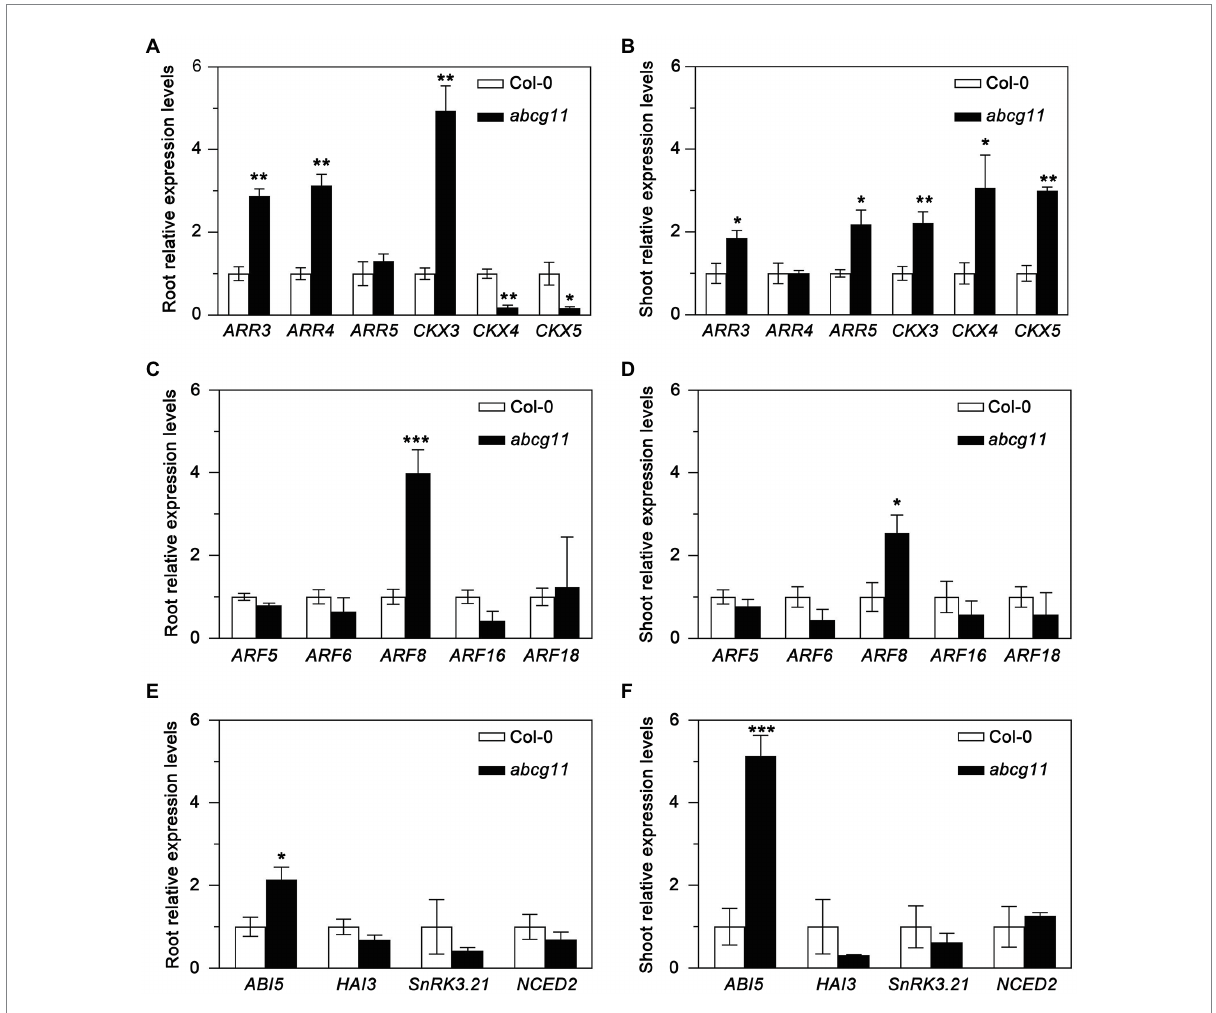
FIGURE 2 Expression of phytohormone-induced genes in Col-0 and the abcg11 mutant. Relative expression levels of cytokinin- (A,B) , auxin- (C,D) , and abscisic acid- (E,F) induced genes in roots (A,C,E) and shoots (B,D,E) . Seedlings were grown vertically on half-strength MS medium for 12 d (16 h light/8 h dark). TUBULIN8 served as an internal control; values for Col-0 were set to 1. Data are shown as means ± standard error (SE; n = 4). Asterisks represent significant differences by Student’s t -test: * p < 0.05; ** p < 0.01; *** p <